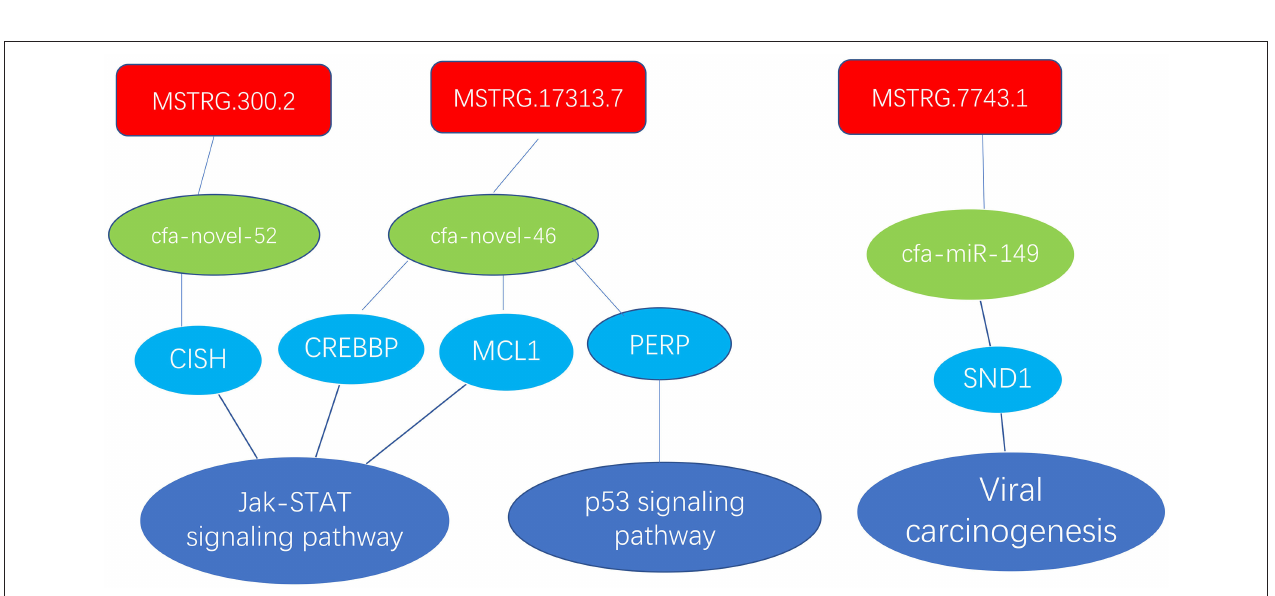
FIGURE 7 | Enrichment of mRNAs in the Jak-STAT signaling pathway, p53 signaling pathway and viral carcinogenesis regulation network; lncRNAs are depicted in red, green represents miRNAs, and blue represents mRNAs.